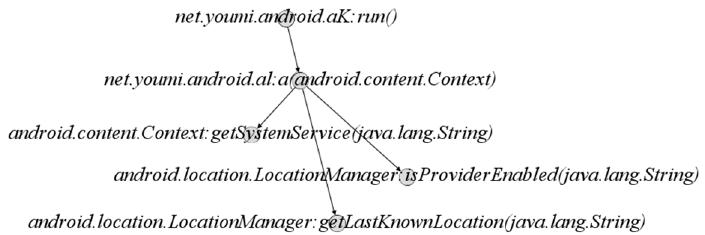
Figure 3. Part of the function call graph of the malware in DroidKungfu (SHA1: a6f39574437c2de53ea881d589408753f2539e3c).